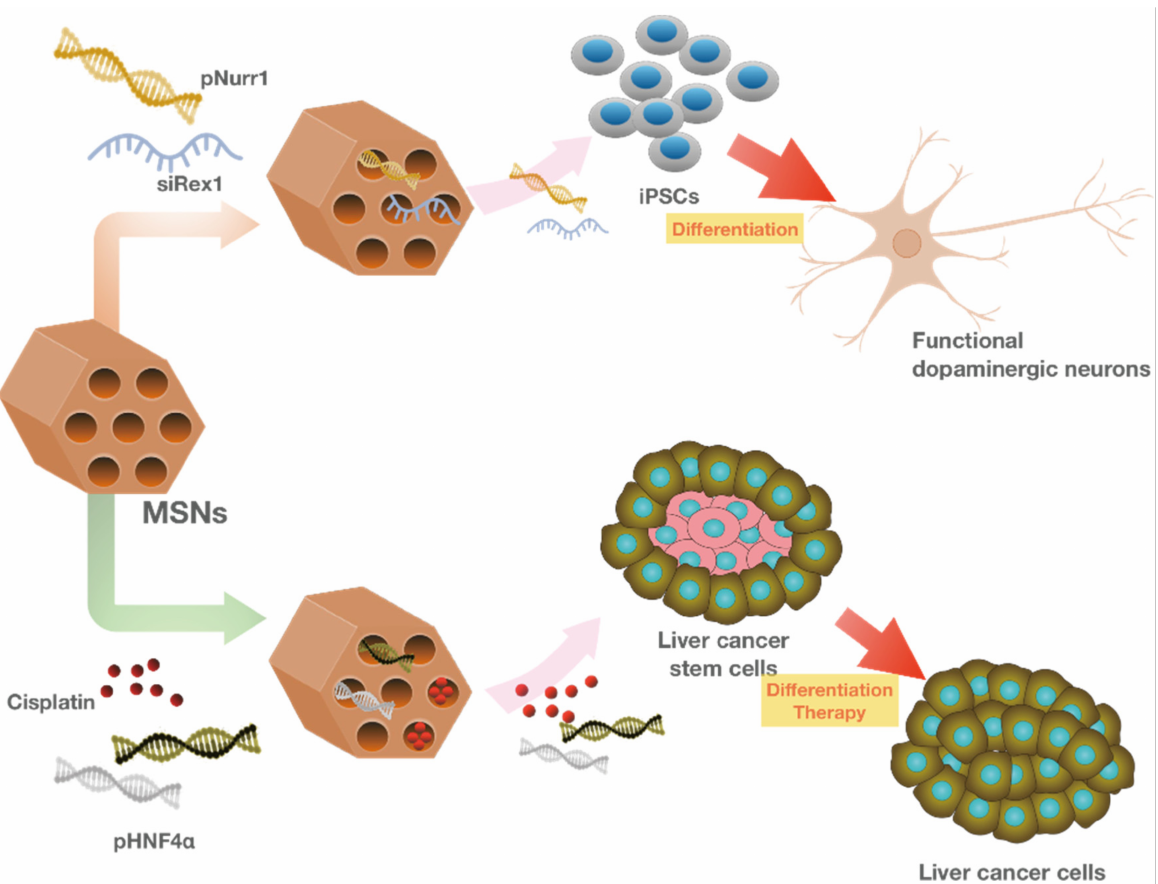
Figure 7. MSNs as multifunctional nanocarriers in stem cell research. MSNs are used as potential delivery nanocarriers that can promote the dopaminergic differentiation of induced pluripotent stem cells or drive malignant cancer stem cells to cancer cells with lower tumorigenic